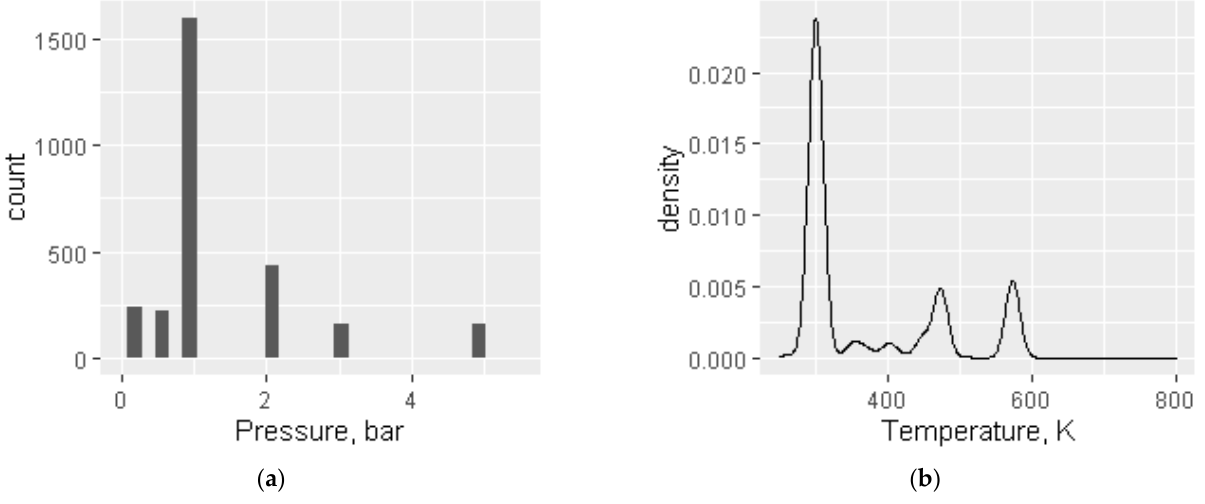
Figure 1. Gathered data statistics [22–47]: ( a ) count against pressure and ( b ) count against temperature.